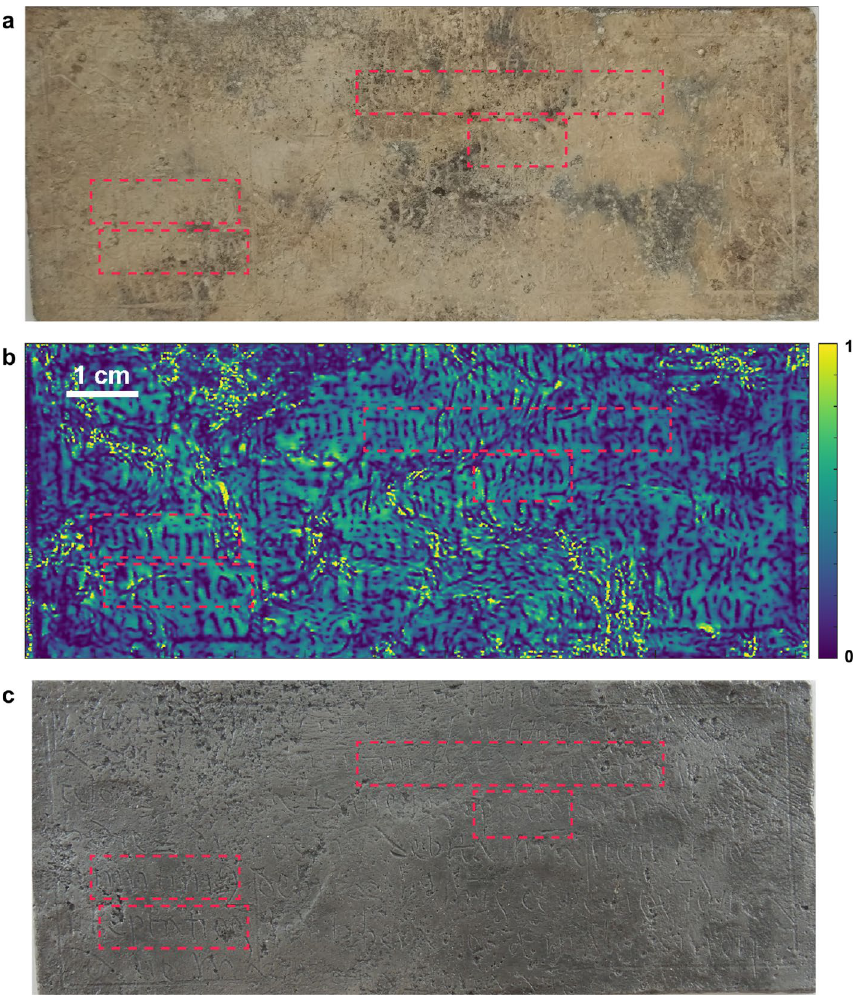
Figure 5. Comparison between the optical and THz images regarding the visualization of inscriptions. ( a ) Photograph of the original Pb cross. ( b ) Final THz image of the Pb cross after post-processing. ( c ) Photograph of the Pb cross after chemically removal of the corrosion. Typical regions are highlighted, in which inscriptions are revealed in the THz image but are barely visible in the optical image before removing the corrosion. As can be read from the THz image ( b ) and confirmed after removal of corrosion ( c ), the inscriptions in the top right boxes are ‘tuum fiat voluntas tua’ and part of ‘quotidianum’ ; the ones in the bottom left boxes are a portion of ‘imittimus’ and ‘tentationem’ ,